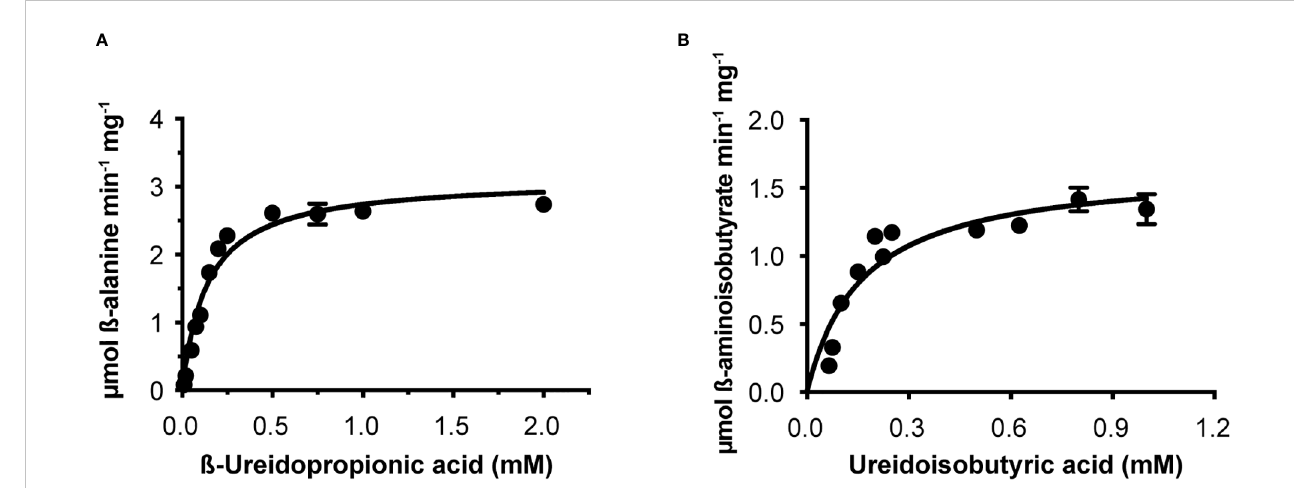
FIGURE 4 Steady state kinetics of puri fi ed recombinant Osß-UP. (A) , Saturation curve for ß-ureidopropionate. (B) , Saturation curve for ß-ureidoisobutyric acid. Data were fi tted to the Michaelis-Menten equation, v = (V max · [S])/(K m + [S]).